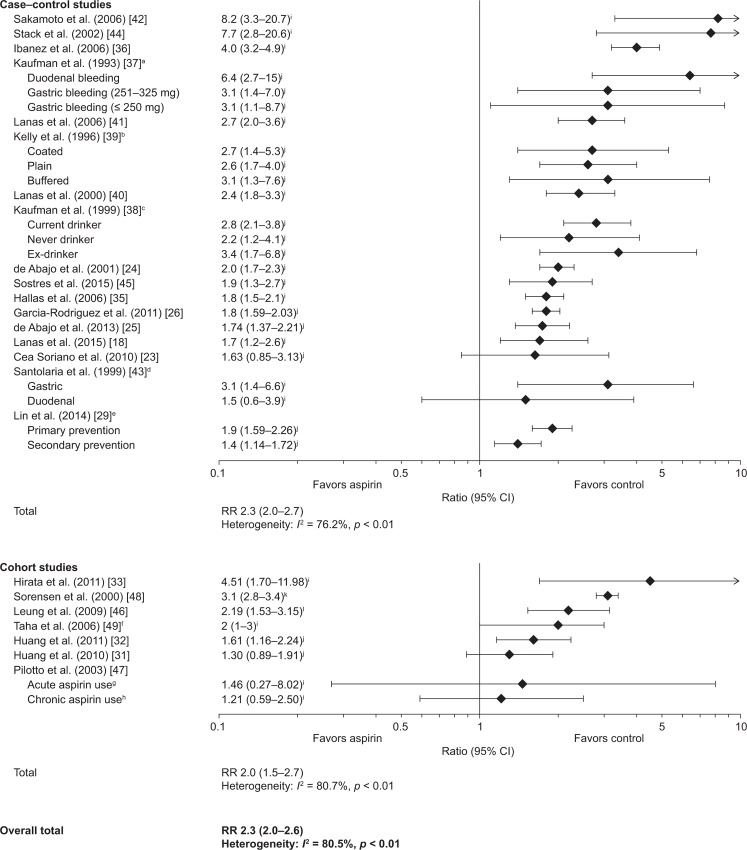
Risk of upper gastrointestinal bleeding with low-dose aspirin: case–control studies and cohort studies.For case–control studies, data are shown as adjusted or multivariate ORs or RRs, plus 95% CIs, for the risk of upper gastrointestinal bleeding with low-dose aspirin vs no aspirin. For cohort studies, data are shown as multivariate ORs, SIR, multivariate HR, or multivariate RRs, plus 95% CIs, for the risk of upper gastrointestinal bleeding with low-dose aspirin vs no aspirin. A test for heterogeneity (I2 statistic) is provided. aData for duodenal bleeding and gastric bleeding (defined as bleeds located in the upper gastrointestinal tract, at sites other than the duodenum) [≤ 250 and 251–325 mg per day]; bData for plain, enteric-coated, and buffered aspirin; cData for different alcohol consumption categories (current drinker/never drinker/ex-drinker); dData for gastric ulcer and duodenal ulcer bleeding (defined as the presence of melena, haematemesis or haematochezia with a substantial decrease in haemoglobin and a peptic ulcer identified endoscopically); eData for primary and secondary prevention; fRisk of erosive esophagitis; gAcute defined as regular or sporadic aspirin use for 5–30 days before endoscopy; hChronic defined as regular aspirin use for more than 1 month before endoscopy; iOR; jRR; kSIR; lHR. CI, confidence interval; HR, hazard ratio; OR, odds ratio; RR, relative risk; SIR, standardized incidence ratio.